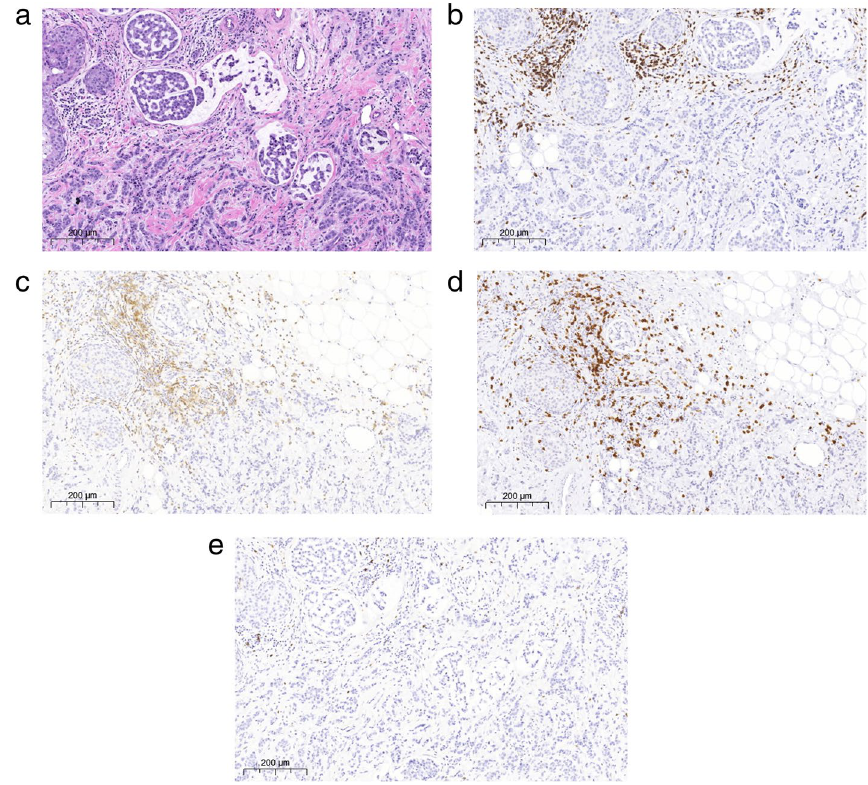
Fig. 1 H&E stain and all immunohistochemical stainings of a PT ( a ) H&E ( b ) CD3 ( c ) CD4 ( d ) CD8 ( e )